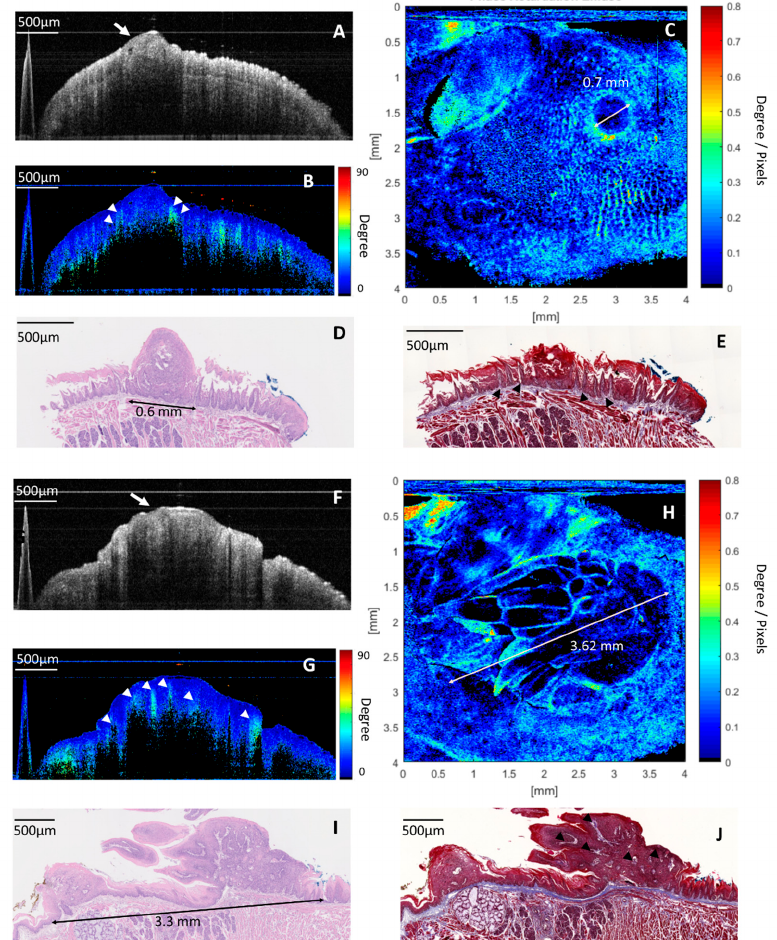
Figure 3. Images of the dysplastic lesion: ( A ) cross-sectional intensity OCT image. A hypo-intensity, a protruding lesion was seen in the EP (white arrow). ( B ) Cross-sectional cumulative PS-OCT image. The protruding lesion showed low retardation, and some highly retardant spikes at the boundary of the EP and LP surrounding the protruding lesion (white arrowheads). ( C ) En-face birefringence map presented a 0.7 mm lesion, with low birefringence in the center and high birefringence in the periphery, the size of the tumor (0.7 mm) is consistent with the histology in Figure 3D (0.6 mm). ( D ) Histology with H&E staining revealed a 0.6 mm papilloma with the dysplastic change, which is compatible with the low-retardance protruding lesion in a cross-sectional PS-OCT image. The expanded and less-retardant dysplastic cell mass explains the low birefringence in the center of the tumor in Figure 3C. ( E ) Histology with Masson’s trichrome staining showed that the collagen–abundant elongated core of the papilla (black arrowheads) at the boundary of the EP and LP surrounding the peripheral of papilloma, which explains the high birefringence at the periphery of the lesion in Figure 3C. Images of the carcinoma in situ (CIS): ( F ) cross-sectional intensity OCT image. A thick, hypo-intensity tumor at the EP was seen (white arrow). ( G ) Cross-sectional, cumulative PS-OCT image. The tumor showed low retardation, and some prominent high-retardant spikes projected from the LP into the low-retardance EP were found (white arrowheads). ( H ) An en-face birefringence map reveals a 3.62 mm lesion with low birefringence in the background and a highly birefringent septum and capsule. ( I ) Histology with H&E staining revealed a 3.3 mm tumor with a full thickness of dysplasia of EP. ( J ) Histology with Masson’s trichrome staining showed that collagen abundance elongated the core of the papilla (black arrowheads) projected from the LP into the EP and separated the dysplastic cell mass. These changes were compatible with the en-face birefringence map, in which the low birefringence background (dysplastic cell mass) was surrounded and separated by a high birefringence capsule and septum (the elongated core of